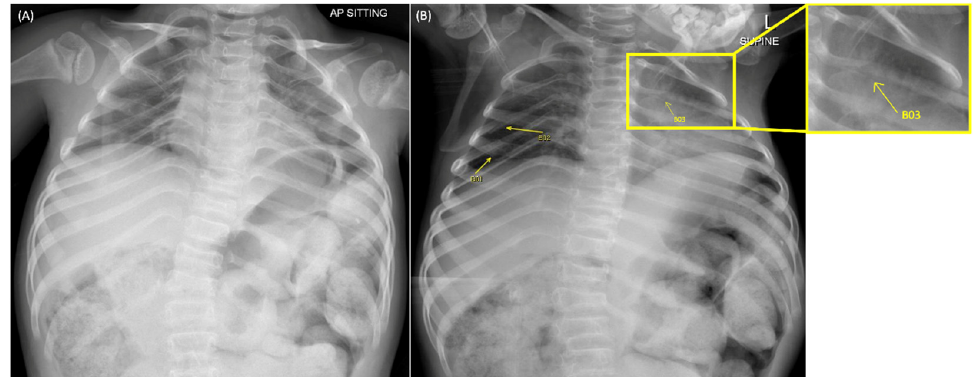
Figure 1. Chest radiographs of the patient; anterior − posterior chest radiograph ( A ) and left oblique chest radiograph ( B ). A right anterior fourth rib healing fracture with callus formation (B01) and a new right posterior fourth rib fracture (B02) were reported by the radiologists. There was a concern from the attending emergency physician about an unreported new fracture at the left posterior third rib (B03; enlarged view in yellow box).